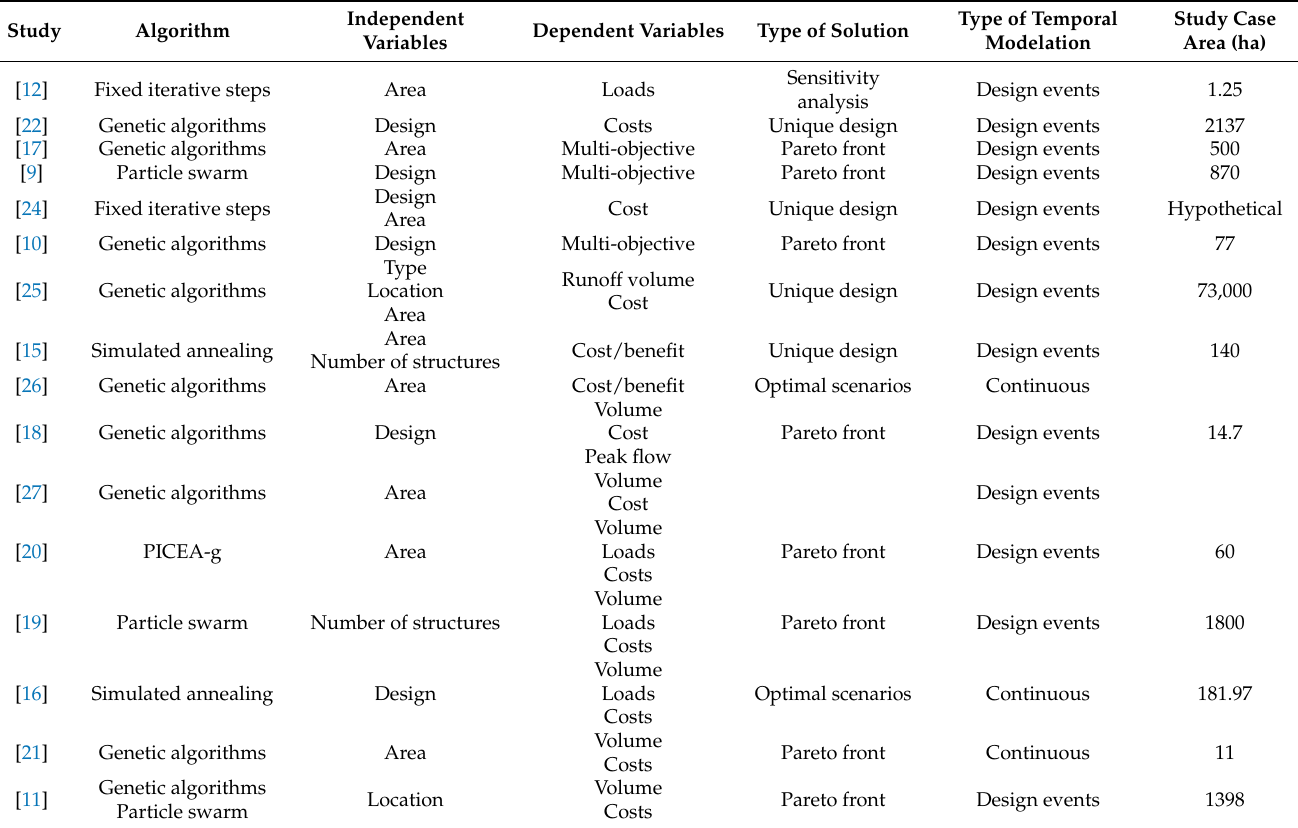
Table 1. Studies including optimization algorithms for